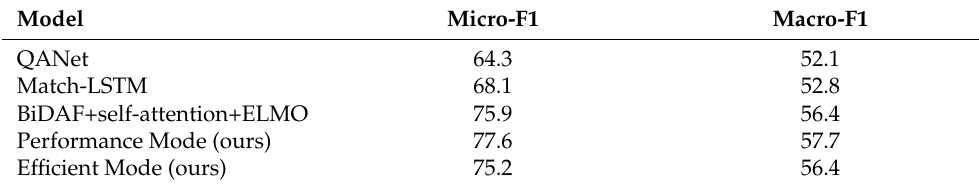
Table 5. Comparisons for different methods based on the MCTest dataset.